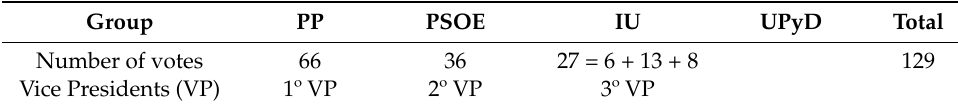
Table 2. Voting of Vice Presidents in the IX Legislature.